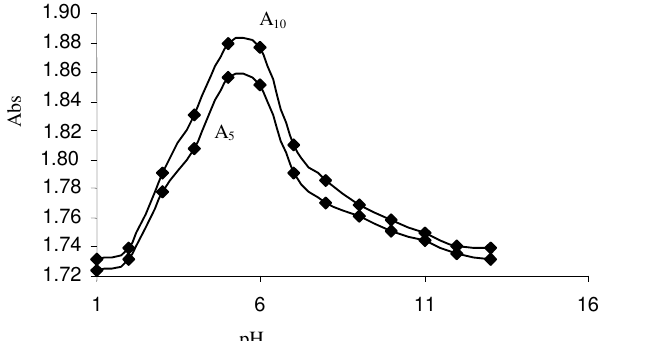
Figure 1. Absorption spectra of reactants and products: (A) [EDTA] = 1 X 10 -3 ; (B) [Fe(CN) = 5 X 10 -4 M (C) [Fe(CN) ] 4 = 4 X 10 -4 M, [EDTA] = 4 X 10 -3 M, [Hg 2+ ] = 3 X 10 -5 M and pH = 5.0 6